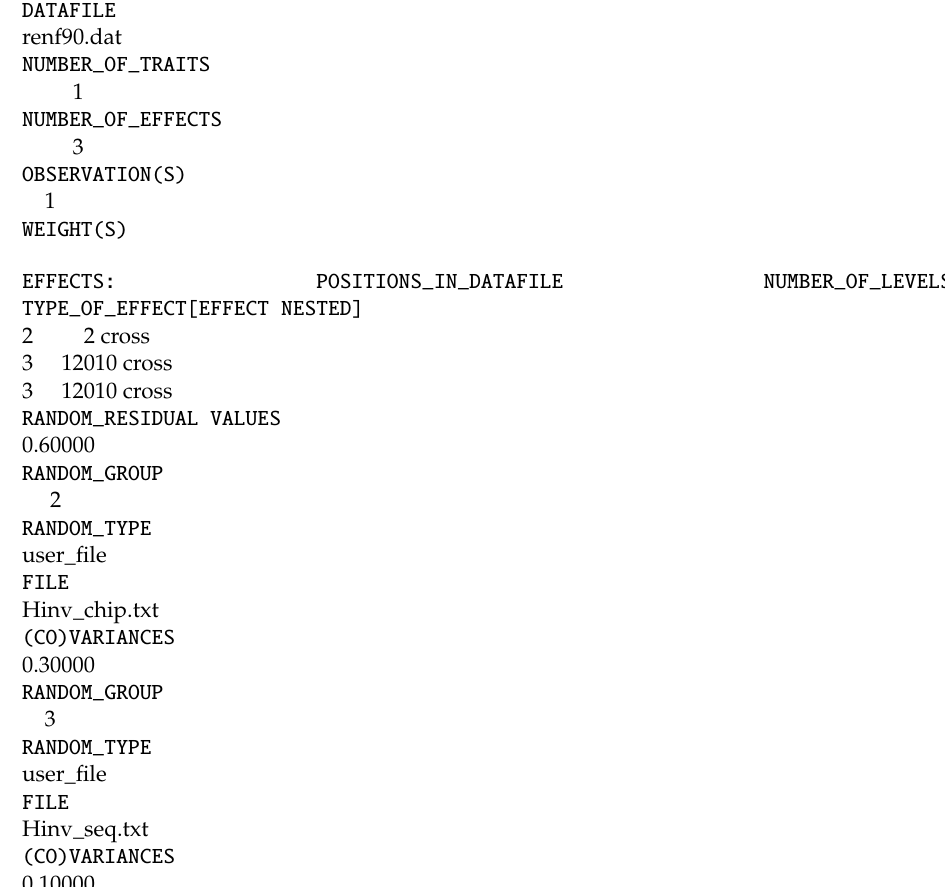
Box 7. Parameter file for running blupf90 using two H − 1